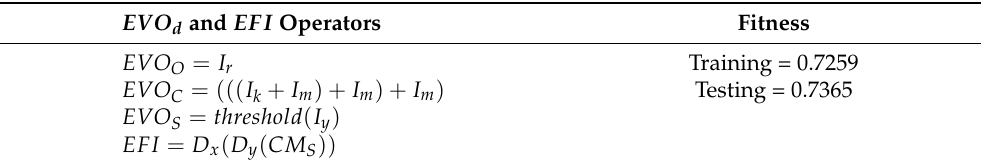
Table 12. Program structure of the operators corresponding to the best solution for the FT database. We select this solution from the 30 executions of Table 11. This final solution is simple: a single color channel and algebraic operations between color channels for the first two visual operators. The third uses a threshold, and the last one applies derivatives.